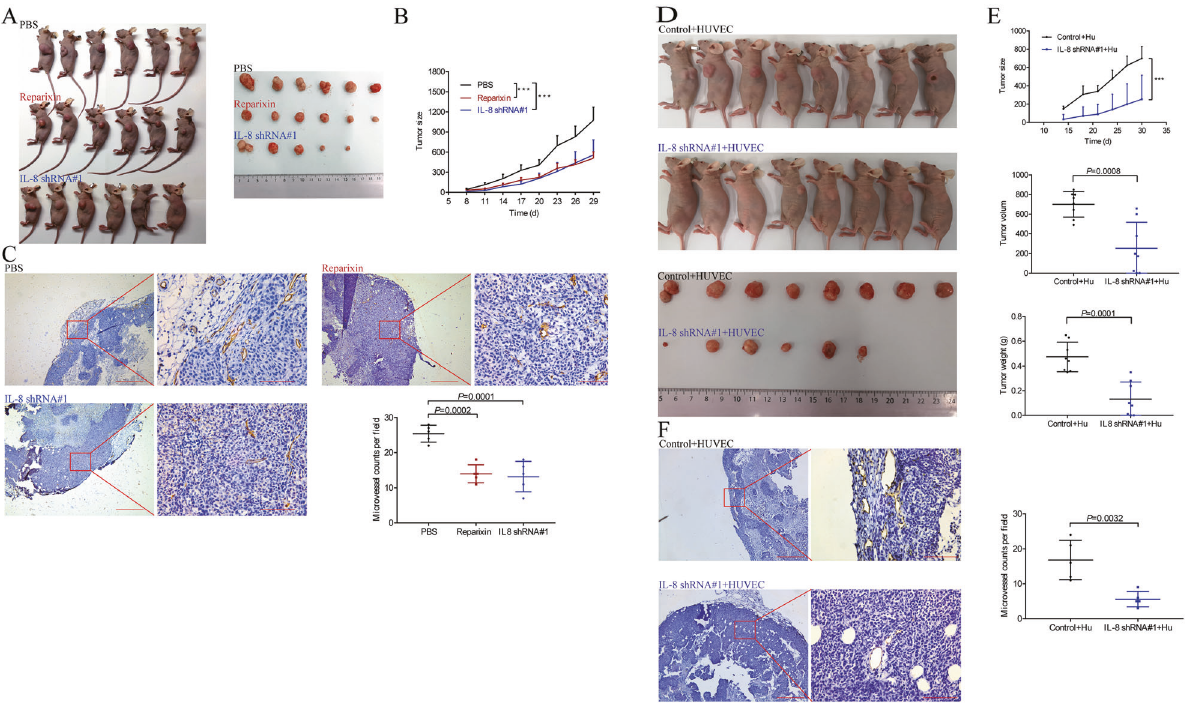
Fig. 6 Effects of inhibiting tumor angiogenesis of IL-8 knock-down and reparixin in vivo. A , D The images of the mice and tumors. B , E Tumor sizes and weights were measured in vivo model. C , F The paraf fi n-embedded tumor tissue sections were immunostained with CD31. Representative tumors are shown. Original magni fi cation, ×40 (scale bars: 200 μ m) and ×400(scale bars: 20 μ m); n = 5. Data in ( B ) are presented as means ± SEM. Data in ( B ) were analyzed with two-way ANOVA test with a Dunnett ’ s post hoc test. Data in ( C – F ) are presented as means ± SD. One-way ANOVA with Tukey ’ s test as post-hoc test was used to assess the difference of data in ( C ). Data in the fi rst ( E ) were analyzed with two-way ANOVA test with a Dunnett ’ s post hoc test. Data in the other ( E ) and ( F ) were analyzed with unpaired Student ’ s t test. * P < 0.05, ** P < 0.01, *** P <